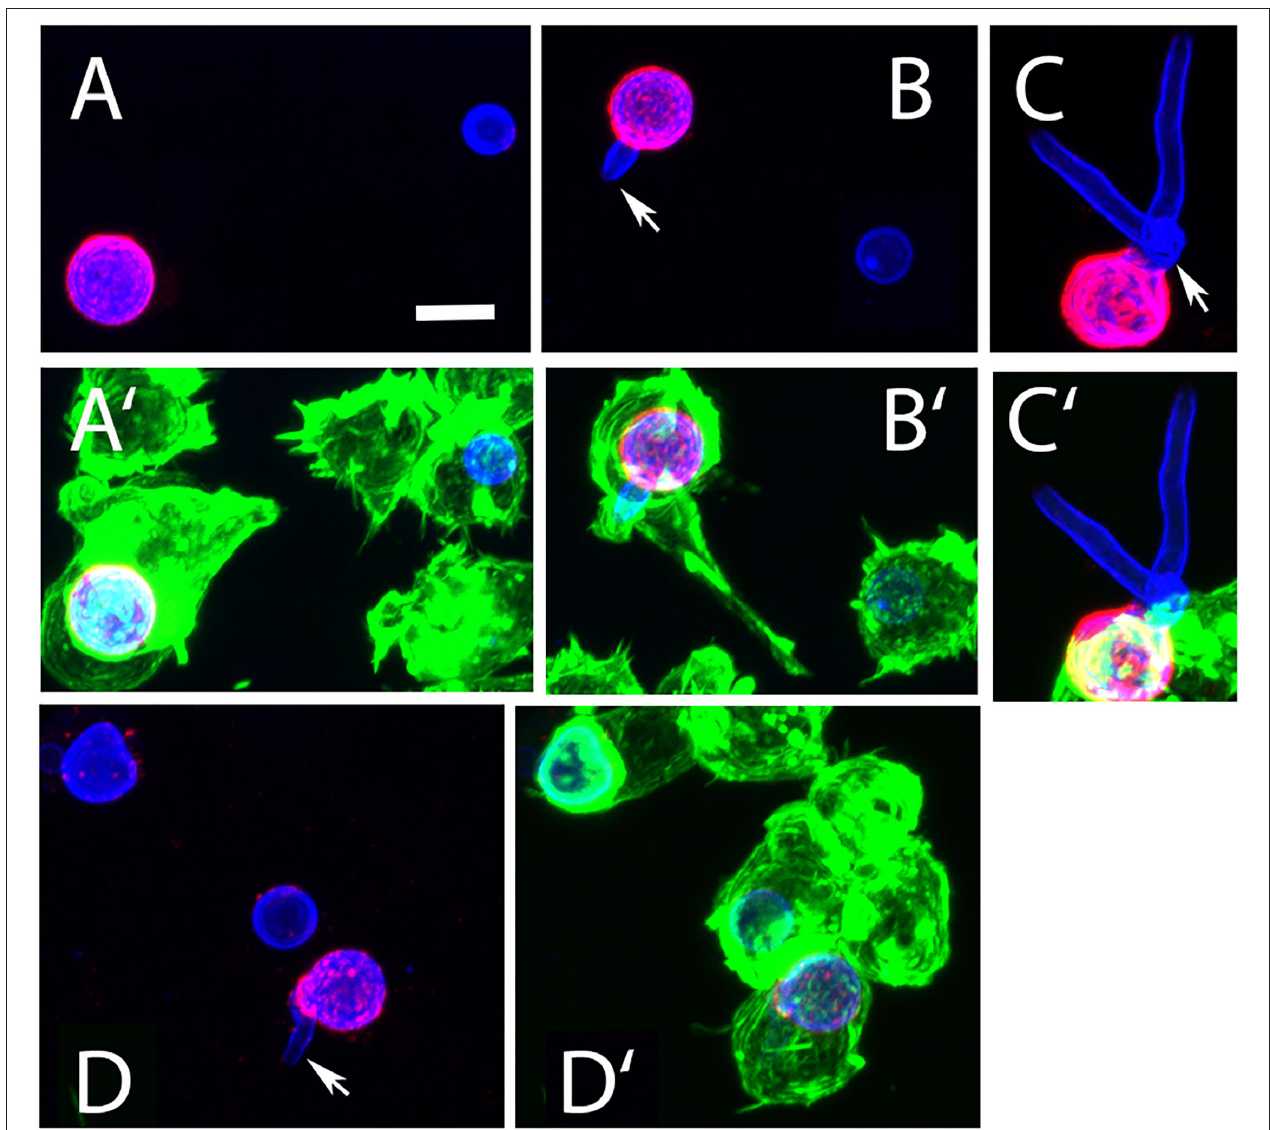
FIGURE 11 | Detection of β -glucan in J774 cells infected with AC. The macrophage cells were infected for 6h, permeabilized with Triton X100, and visualized using phalloidin-FITC (green) AC were stained with Calcofluor white (blue) and the β -glucan-specific mab 2G8 (red). (A ′ –D ′ ) show overlays of all three colors, the corresponding images without the green channel are depicted in (A–D) . All panels show maximum intensity projections. The arrows in (B–D) indicate AC that had initiated germ tube formation and were strongly stained with 2G8. The bar in (A) represents 5 µ m and is valid for all